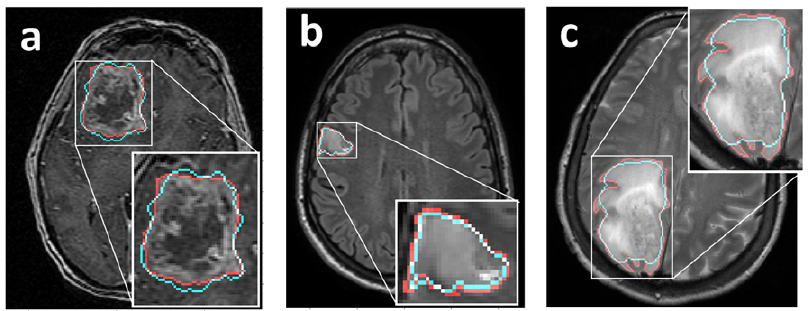
Figure 3. Spatial comparisons between baseline pre-treatment MRI (red outline) and simulation results (cyan outline) seeded with our initial condition. a: large tumor on T1GdMRI . b : smaller tumor on FLAIR MRI. c : Highly anisotropic tumor growth on T2-weighted MRI. Our simulations produce tight spatial matches to a range of tumors ( a and b ), but decrease in accuracy for tumors with high anisotropy ( c ).